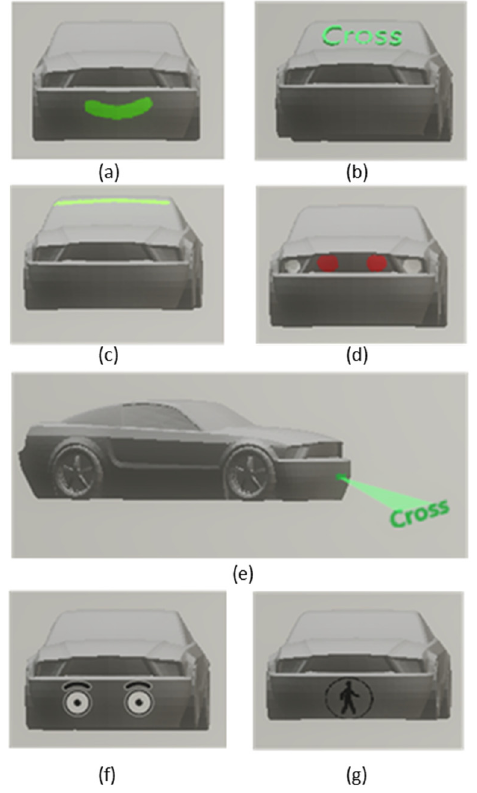
Figure 1. Different eHMI technologies: ( a ) smiling display: using a smile on the front of the car to deliver information to the external user, ( b ) display on the windshield showing in text information what the pedestrian should do, ( c ) LED light strip on the windshield in different motion sequences according to the message, ( d ) front brake lights: send brake information to the front, so you do not rely solely on the perception of deceleration, ( e ) projection of messages on the road: with text elements or crosswalk, enabling the “safe crossing” option to the pedestrian, ( f ) vehicle has a human-like appearance with eyes to show detection, ( g ) icon of yield on, as well as pedestrian crossings.